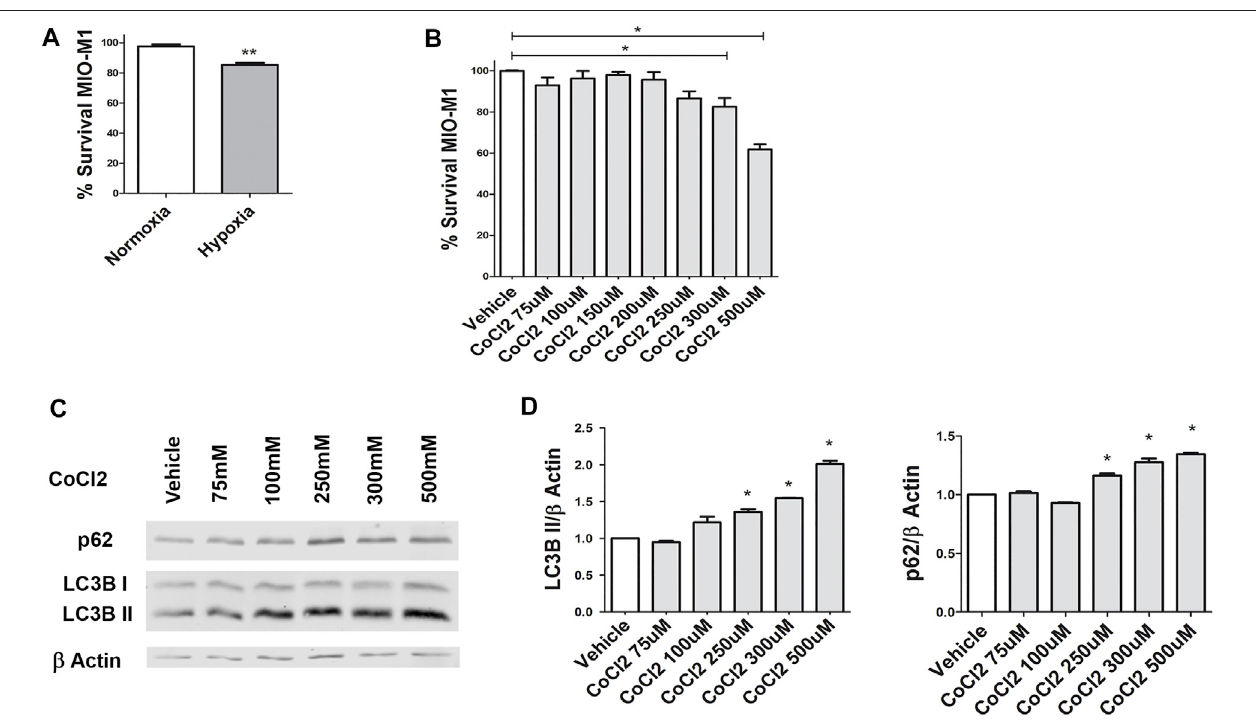
FIGURE 1 | Effect of hypoxia (gas or CoCl 2 ) on human MIO-M1 viability by MTT assay. (A) Viability of MIO-M1 cells exposed to 24 h hypoxia (1% O 2 ) or normoxia. (B) Viability of MIO-M1 cells exposed to increasing concentrations of CoCl 2 during 24 h. The cell viability was evaluated by MTT assay and measured by spectrophotometry. (C) Representative Western blot of autophagy markers, LC3B II and p62, from cell lysates of MIO-M1 incubated with increasing concentrations of CoCl 2 during 4 h β -actin is shown as a loading control. (D) Protein levels of LC3B II and p62 were quanti fi ed by densitometry and normalized by β actin. Data is presented as mean ± SEM. * p < 0.05, ** p < 0.01. Graph shows results of three independent experiments.